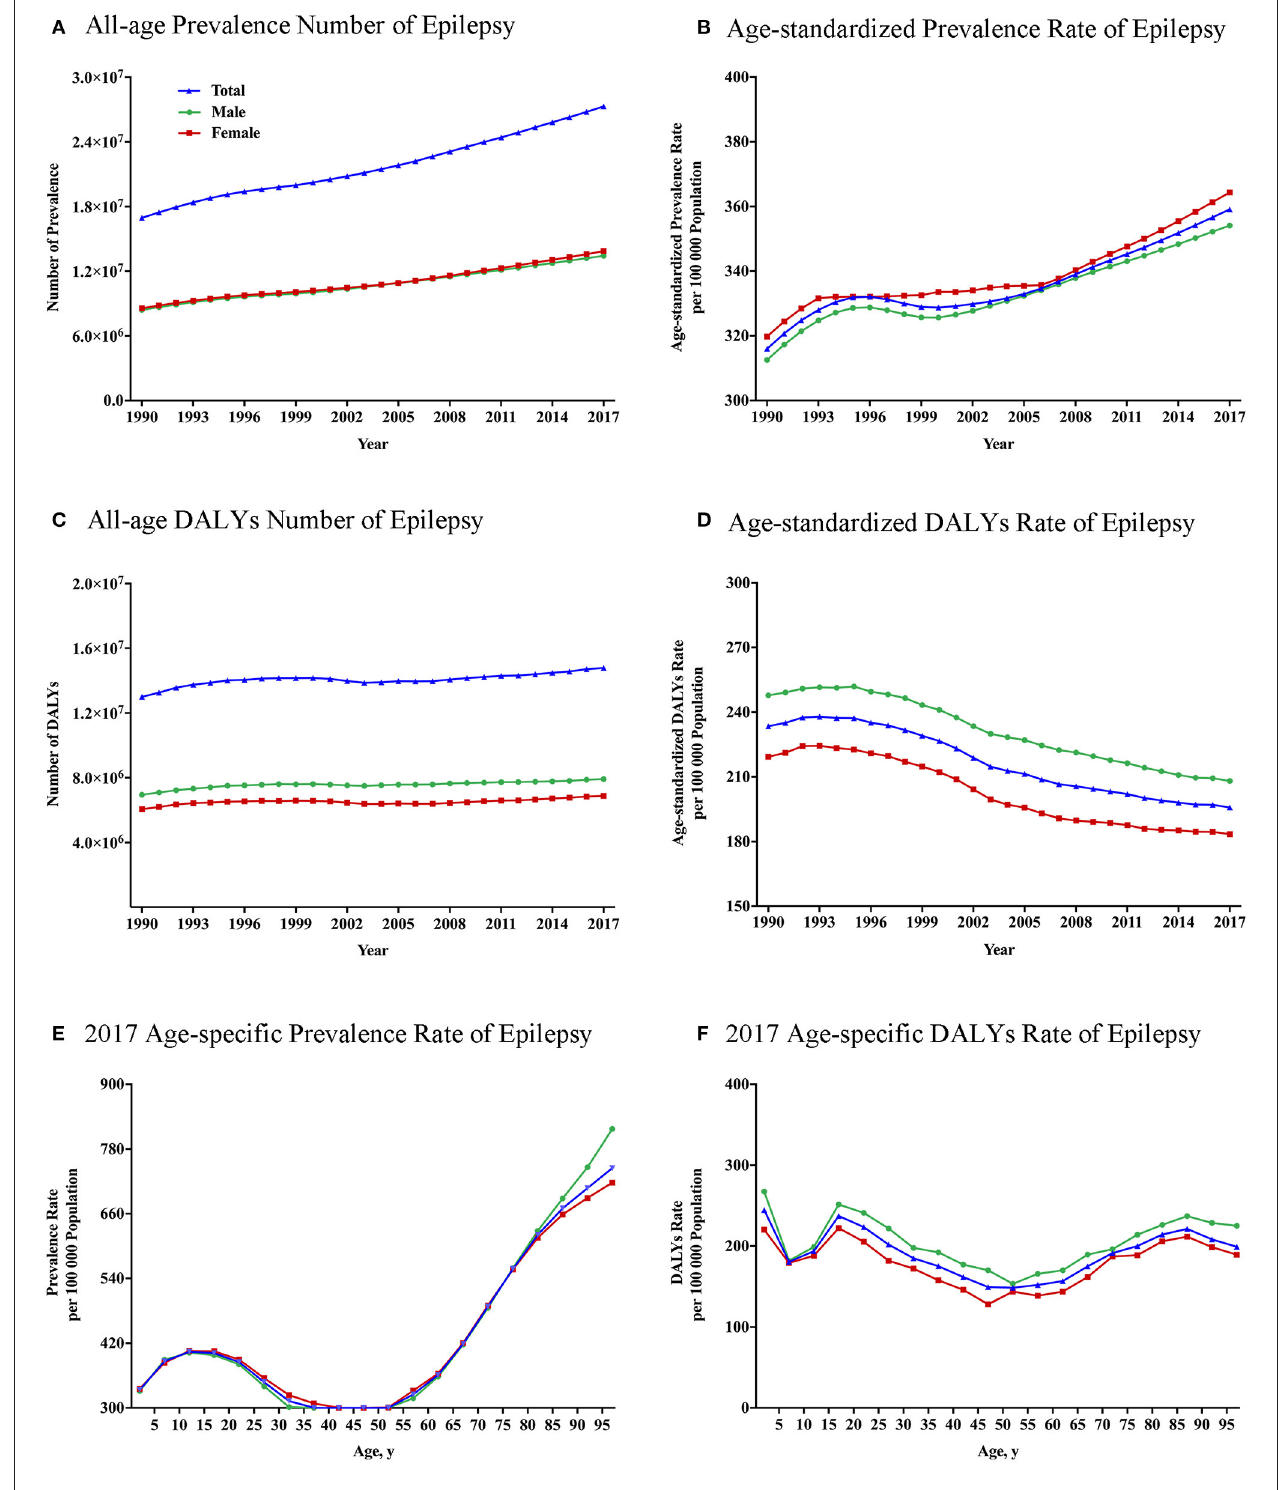
FIGURE 1 | Global total and gender-specific burden of epilepsy by year and age. (A) All-age prevalence numbers from 1990 to 2017. (B) Age-standardized prevalence rates per 100,000 population from 1990 to 2017. (C) All-age DALY numbers from 1990 to 2017. (D) Age-standardized DALY rates per 100,000 population from 1990 to 2017. (E) Age-specific prevalence rate in 2017. (F) Age-specific DALY rate in 2017. DALYs, disability-adjusted life-years.